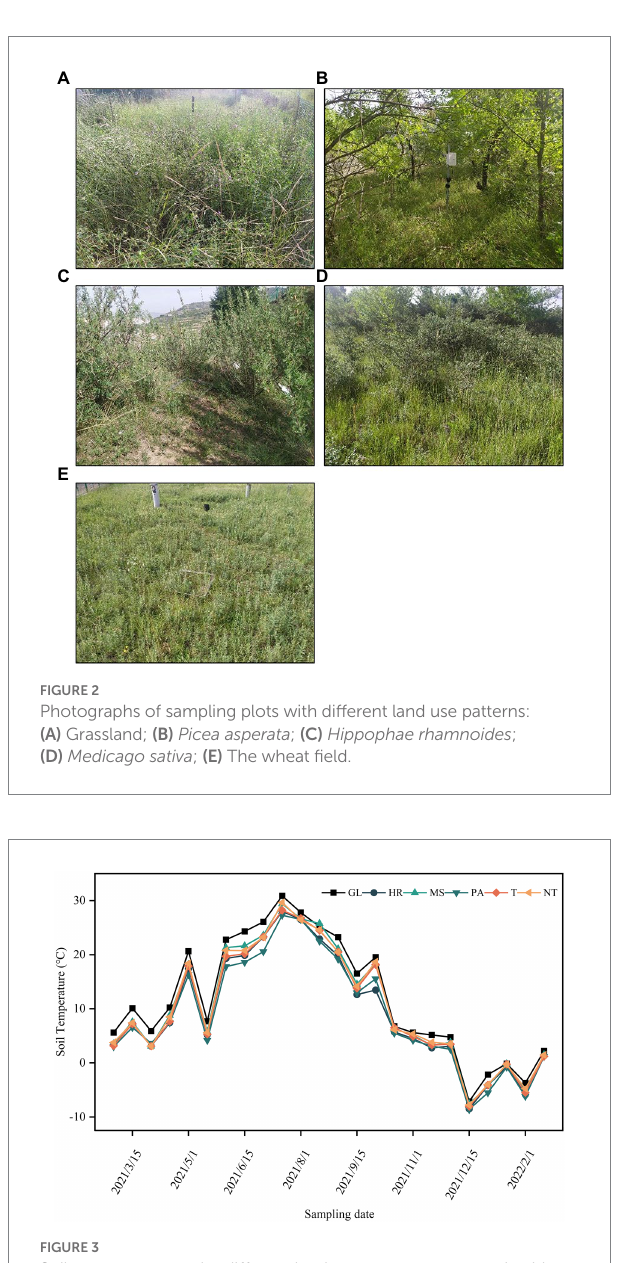
TABLE 2 Soil physicochemical properties at 0–20 cm under different land use patterns.